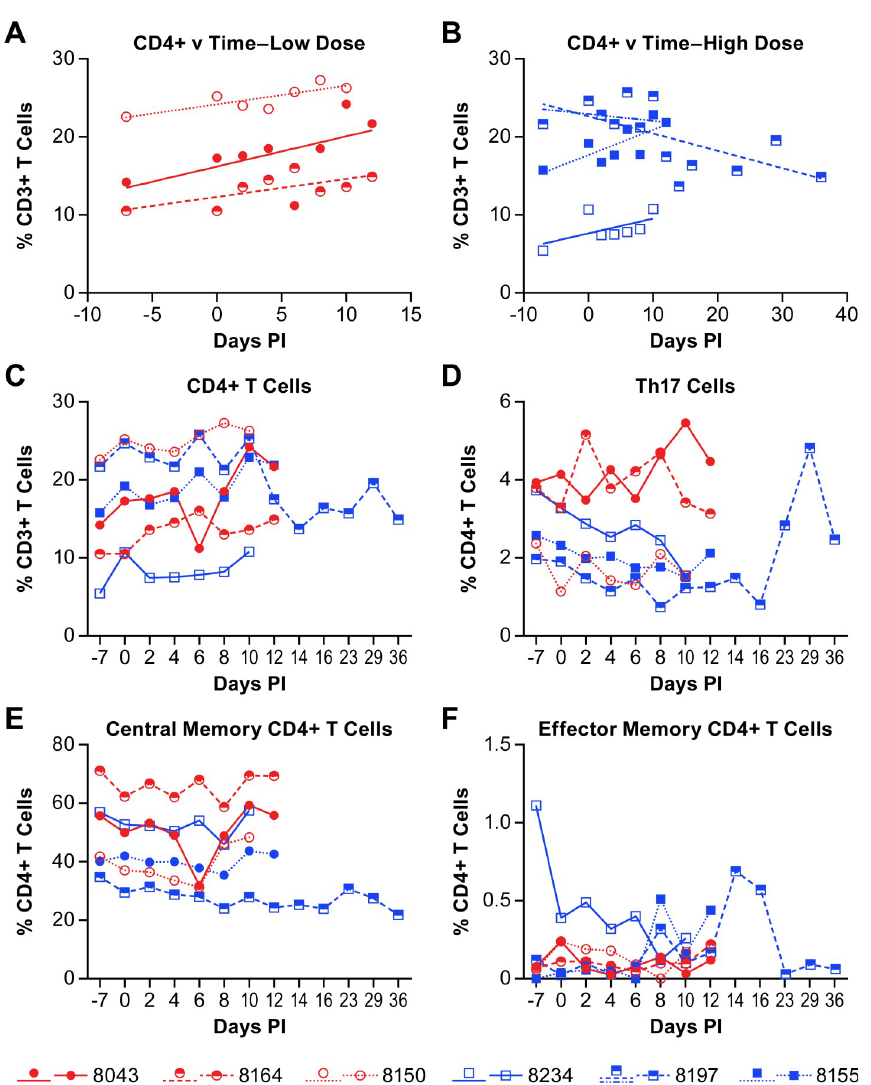
Fig 5. Changes in CD4+ T cell populations in animals infected with NiV. The percent of CD4+ T cells within the CD3+ cell population of individual animals is provided in panels A-C. Linear regression analysis of the low dose group (A) and high dose group (B) was performed to determine the rate of change of the CD4+ T cell population over the course of disease. The r-values for the linear regression analyses are provided in S1 Table. Linear regression analysis was performed on samples from all animals through day 12 (acute phase) with additional analysis of the surviving animal over the entire course of disease (blue dashed line). The population of Th17 cells (D), central memory CD4+ T cells (E) and effector memory CD4+ T cells (F) were determined within the total population of CD4+ cells. The cell surface markers for defining individual populations is provided in S3 Table. remaining two animals (Fig 6A, 6B and 6E; S1 Table). The population of CD8 bright T cells decreased in four of six animals, while in one of the animals the slope of the population change was approximately 0 (Fig 6C, 6D and 6F; S1 Table). The remaining animal, the survivor, had a nominal increase in the CD8 bright population over the acute phase of disease and the popula- tion increased further as the animal convalesced (Fig 6D and 6F; S1 Table). To further delineate CD8+ T cell populations, CD8+ central and effector memory T cells were quantified over the course of disease. The populations of CD8 dim central memory cells